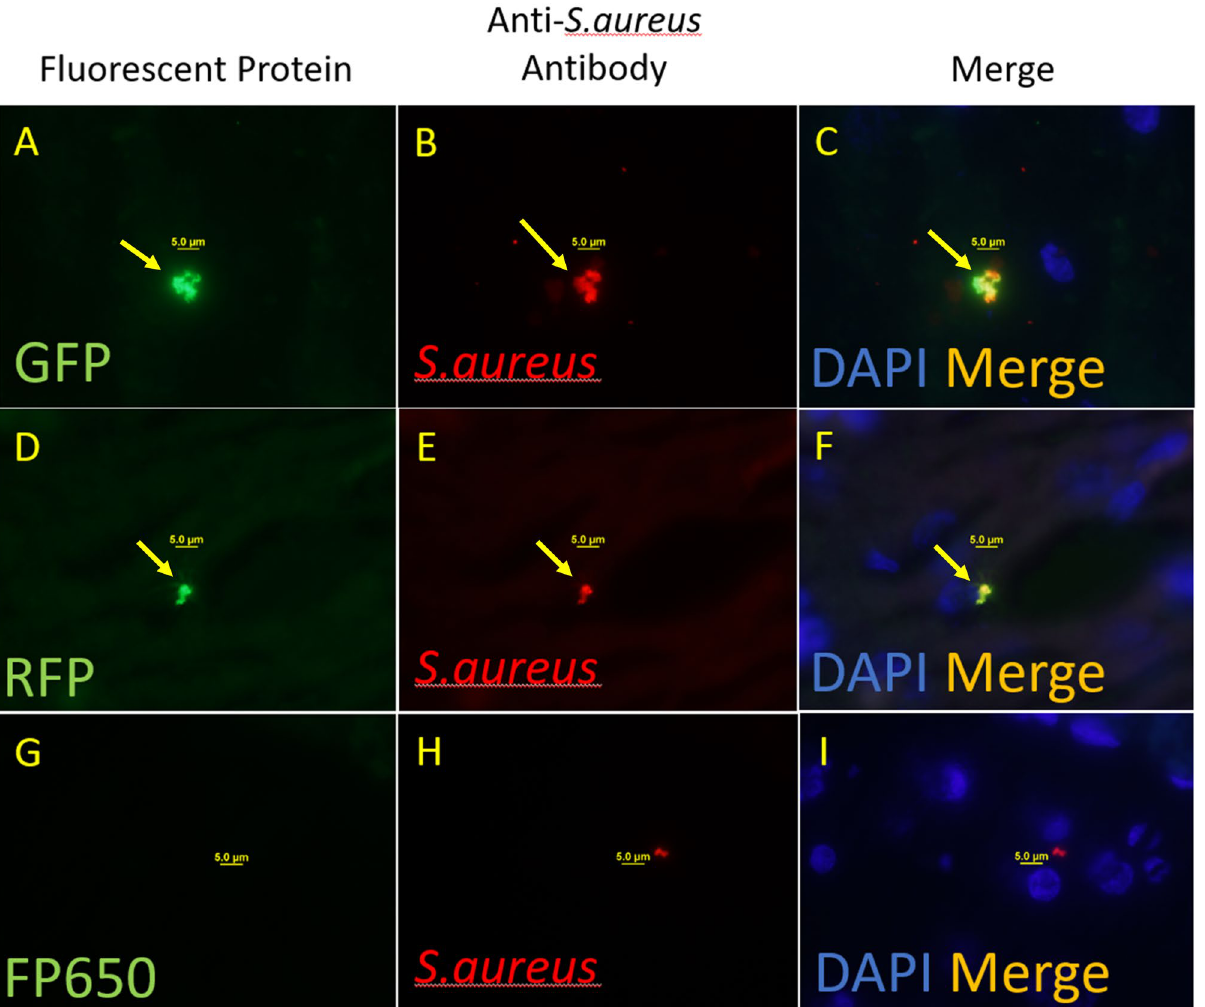
Figure 2. Fetal cerebral cortex double immunofluorescence stain with anti-fluorescent protein antibody (green fluorescence), anti- S.aureus bacteria (red fluorescence), and DAPI in blue. ×100 magnification: ( A ) GFP (Green), ( B ) S. aureus (Red), ( C ) Merge images of GFP staining. ( D ) RFP (Green), ( E ) S. aureus (Red), ( F ) Merge images of RFP staining. ( G ) FP650 (Green), ( H ) S. aureus (Red), ( I ) Merge images of FP650